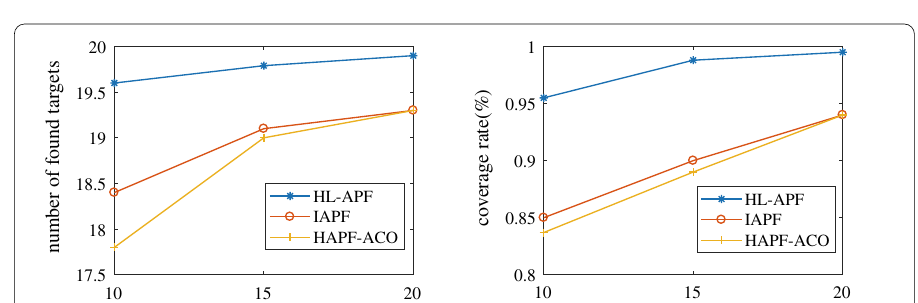
(b) Comparison on coverage rate of different three algorithms.